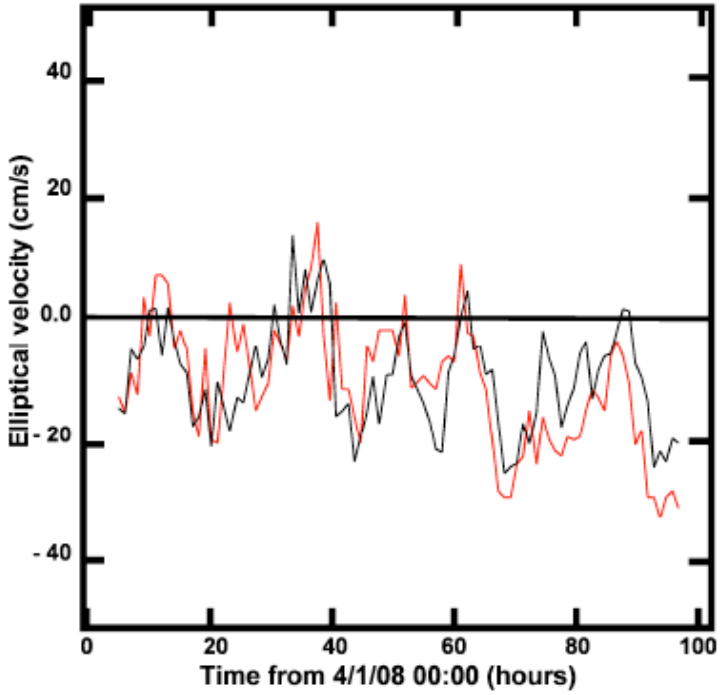
Figure 16. Time series of radial velocities measured at the point shown in Figure 15. Black—calculated from total velocity vectors produced by COMM, FORT. Red—measured by DRAK.